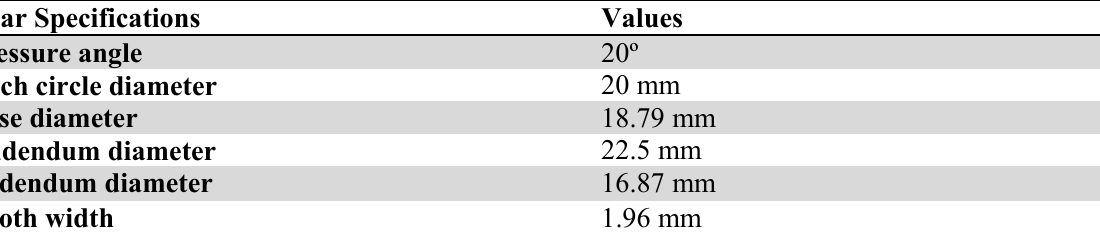
Gear specifications used in the experimentation